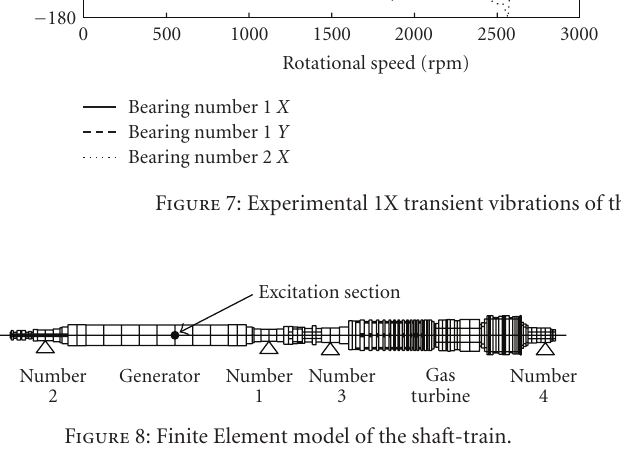
means of a set of simple mechanical systems, having only two degrees of freedom, described using lumped parameters [13,